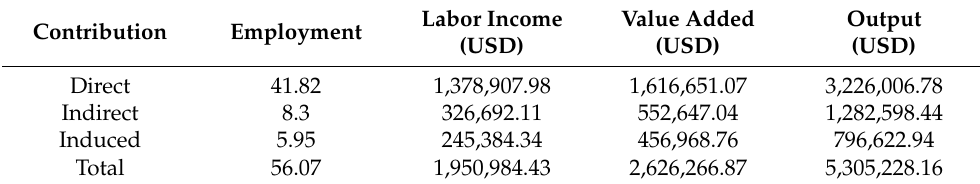
Table A16. Contribution of South Slough Spending to Coos County (Annual).